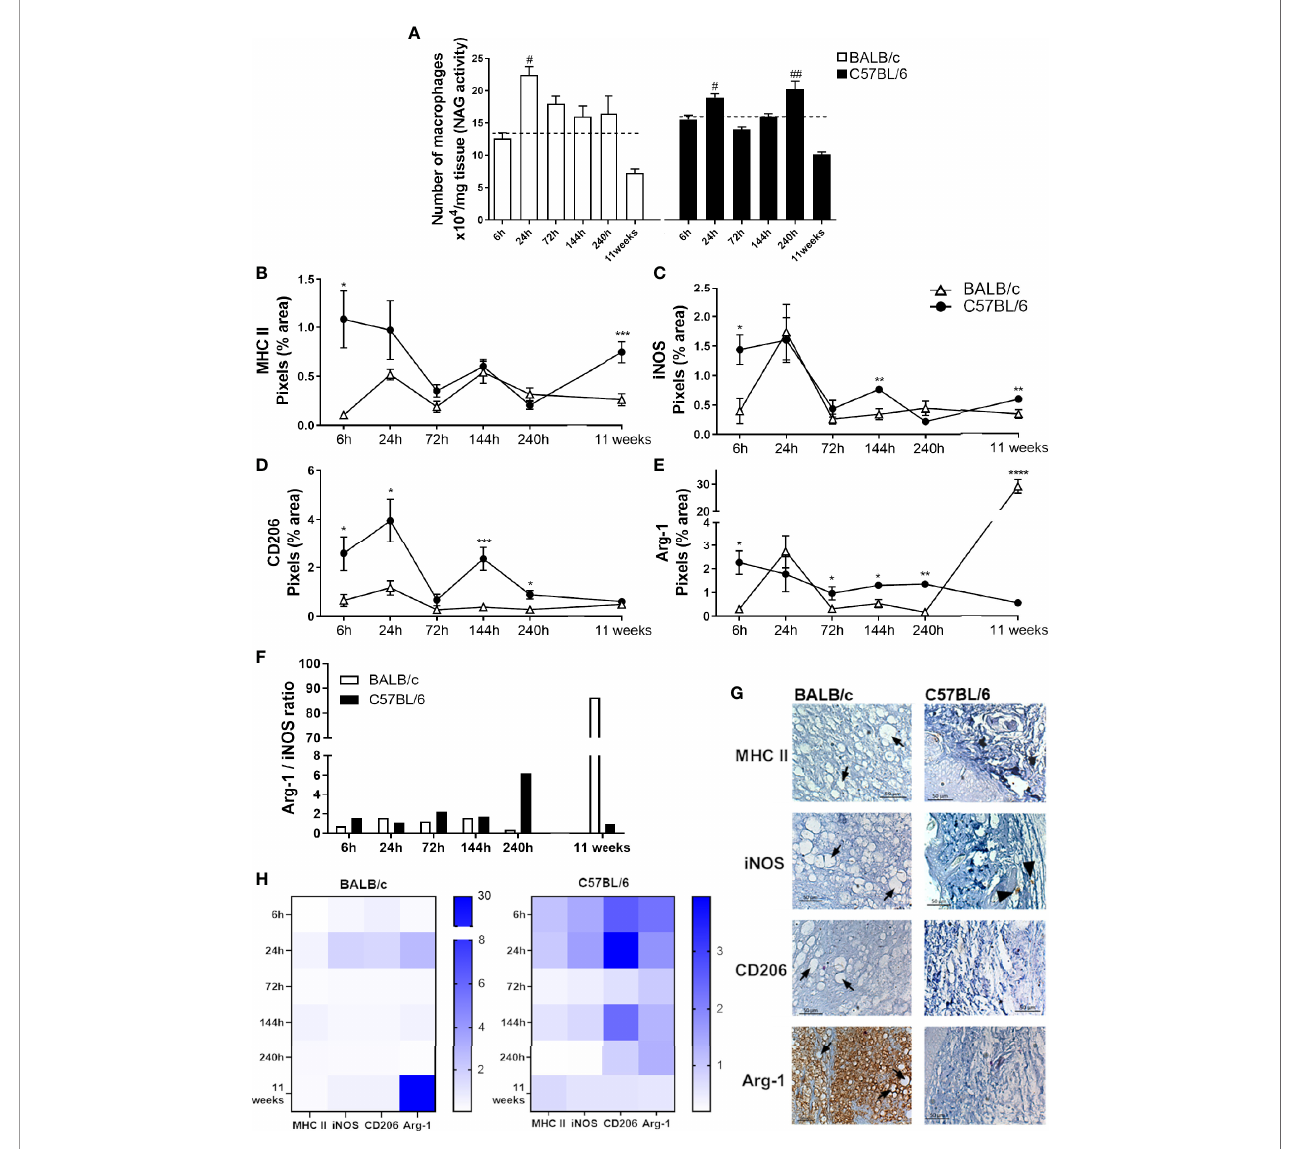
FIGURE 4 | Characterization of local macrophages in infected mice paws. (A) Indirect measurement of the macrophage number by NAG activity. (B) Immunohistochemical quanti fi cation of MHC-II, (C) iNOS, (D) Arg-1, and (E) CD206 staining in the paw of infected mice. # Signi fi cant difference in relation to the non- infected mice (dashed lines), p ≤ 0.05; ## p ≤ 0.01. *Signi fi cant difference between BALB/c and C57BL/6 mice infected with L. amazonensis , p ≤ 0.05; **p ≤ 0.01, ***p ≤ 0.001, ****p ≤ 0.0001. (F) Arg-1/iNOS ratio. (G) Representative fi gures of immunohistochemical labeling. The positive marking on immunohistochemistry sections corresponds to the brown areas (arrowhead). Arrows indicate vacuolated macrophages fi lled with parasites. (H) Heatmap of MHC-II, iNOS, Arg-1, and CD206 in all evaluated time points. Data from (A – E) represent the mean ± SEM (n ≥